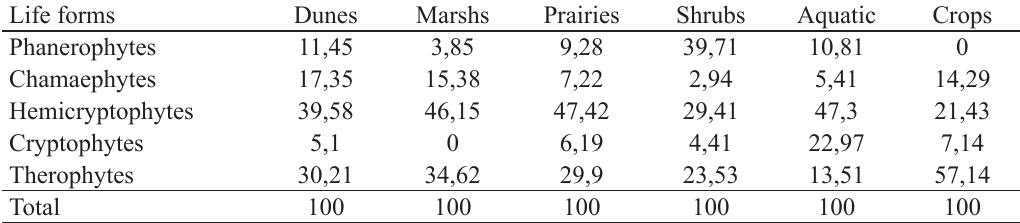
Table 5. Biological spectra according to the species by life form in the study area plant formations. Life